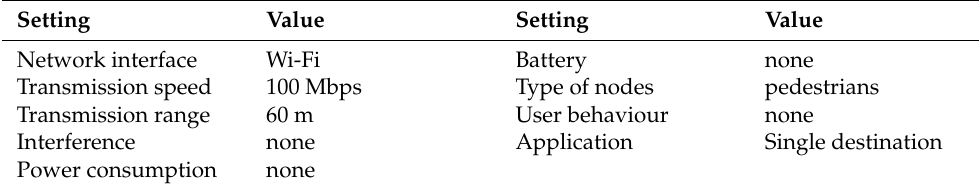
Table 2. Summary of the common simulation settings for all the